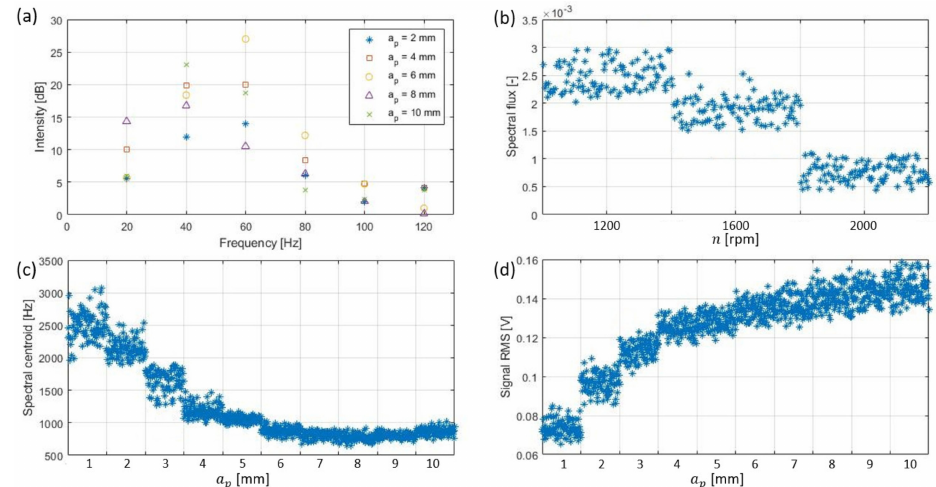
Figure 6. Harmonic intensity of signals with different depths of cut ( a ), spectral flux of signals with different spindle speeds ( b ), spectral centroid of different depths of cut ( c ) and RMS of different depths of cut ( d ).